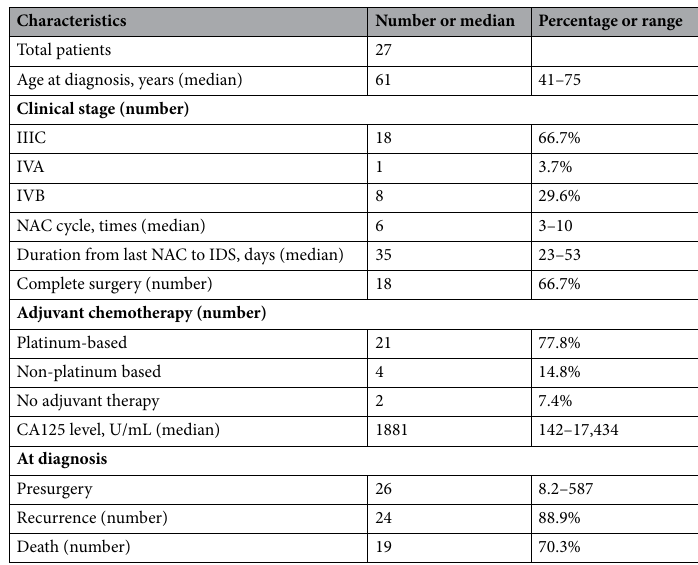
Table 2. Patients’ background. NAC neo-adjuvant chemotherapy, IDS interval-debulking surgery.